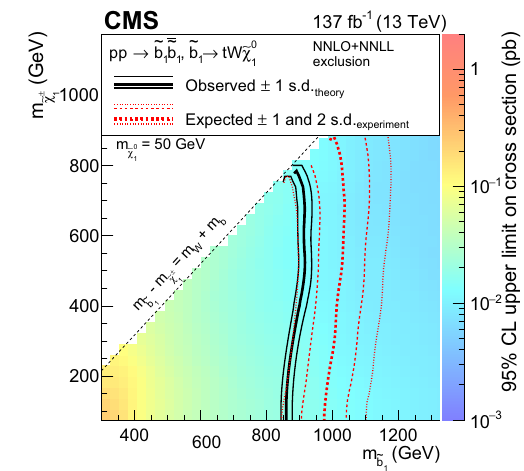
Fig. 10 Exclusion regions at 95% CL in the plane of m ˜ χ ± for the T6ttWW model with m ˜ χ 0 Fig.